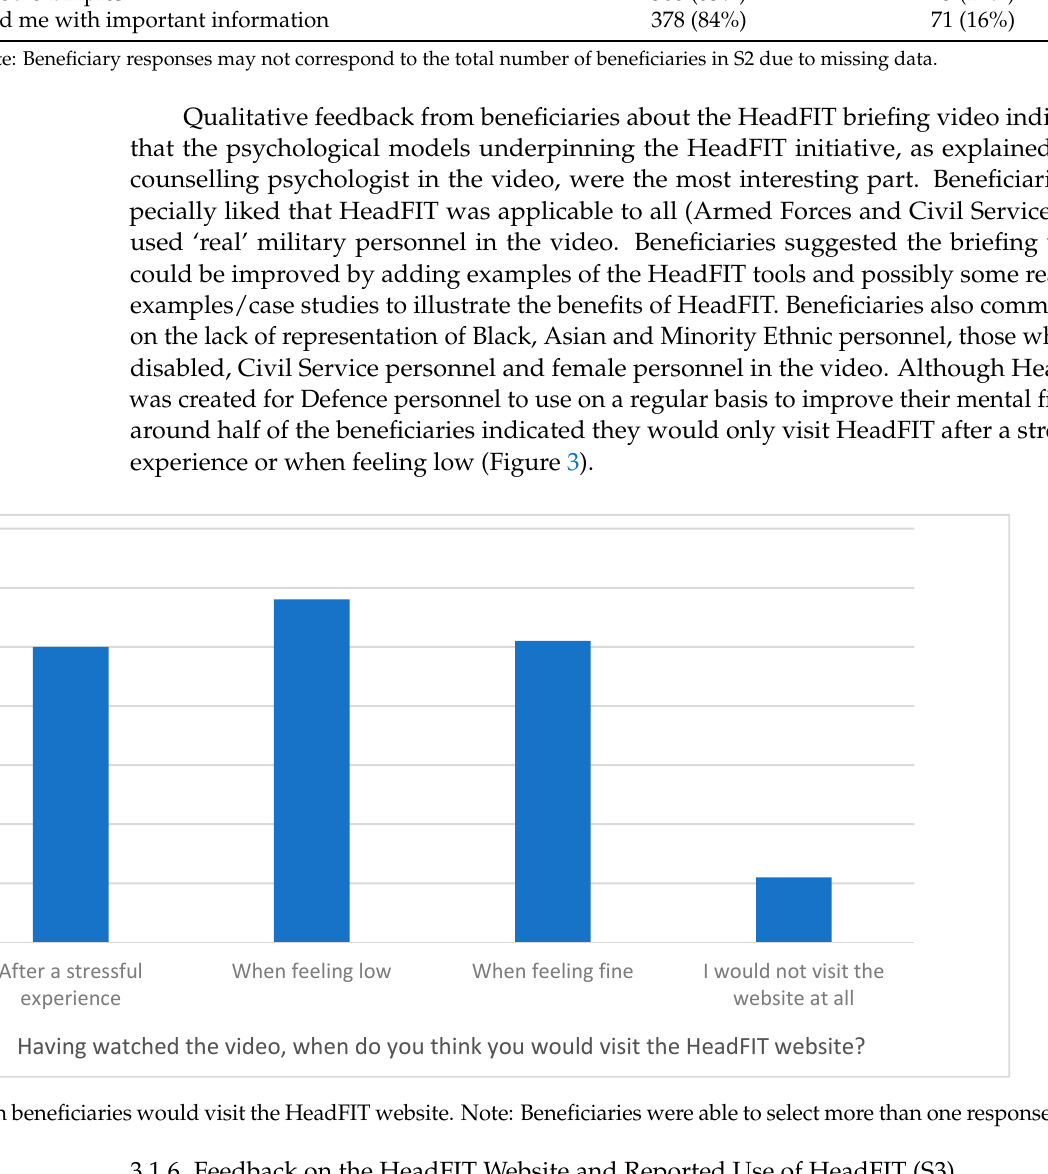
Table 3. Beneficiaries Feedback on the HeadFIT Briefing Video.